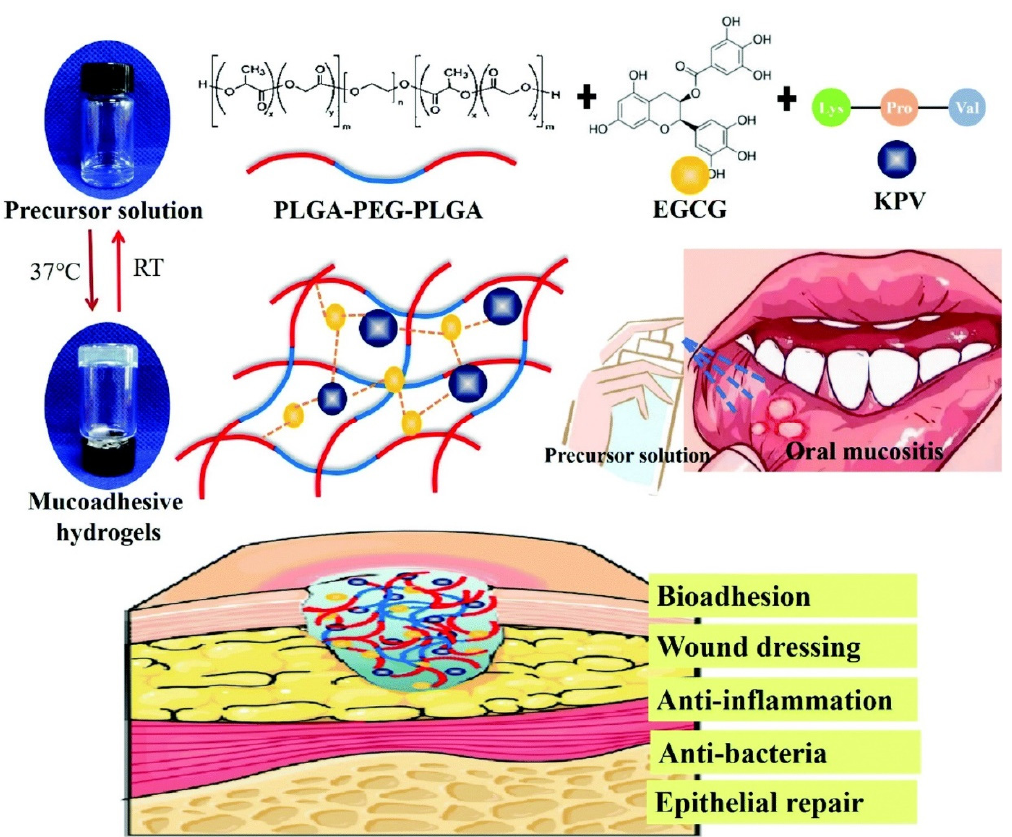
Figure 7. Scheme of mucoadhesive KPV@PPP_E hydrogel for chemotherapy-induced oral mucositis. Reprinted with permission from Ref. [58] Copyright 2022 Royal Society of Chemistry.